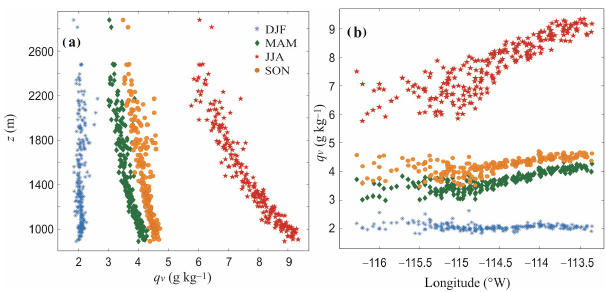
Figure 6. Mean seasonal specific humidity vs. (a) elevation and (b) longitude, for all sites. Values are a composite of 5 years in each seasonal record (i.e., average specific humidity at each site over 15 months). Winter (DJF) is shown in blue asterisks, spring (MAM) in green diamonds, summer (JJA) in red stars, and autumn (SON) in orange